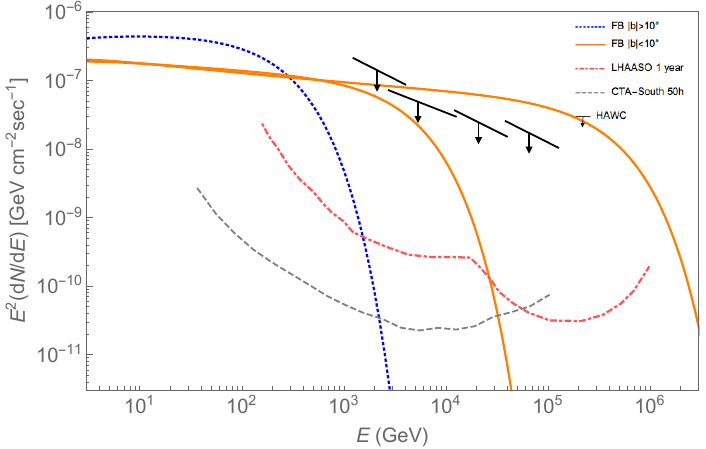
Figure 4. FB spectra from the low- and high-latitude regions and HAWC upper limits as shown in Figure 2. The differential point source flux sensitivities of the CTA southern site [32] with 50 h of observation (gray dashed curve) and of the LHAASO [33] with one year of observation (red dot-dashed curve) are shown with the FB flux models for illustration